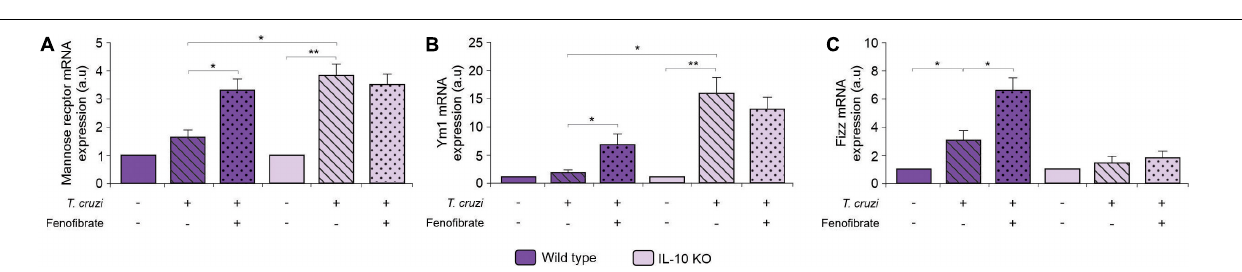
FIGURE 9 | Effect of T. cruzi infection and fenofibrate treatment on the expression of M2 markers. The level of transcription of Mannose Receptor (A) , Ym1 (B) , and Fizz (C) was determined by qRT-PCR in heart homogenates from uninfected, T. cruzi- infected, and T. cruzi- infected fenofibrate-treated WT and IL-10 KO mice. Differences between groups were analyzed by ANOVA (mean ± SEM) followed by Tukey post hoc test. Differences were considered significant when p < 0.05. 7 mice per group, 3 replicate experiments. * p < 0.05 and ** p <